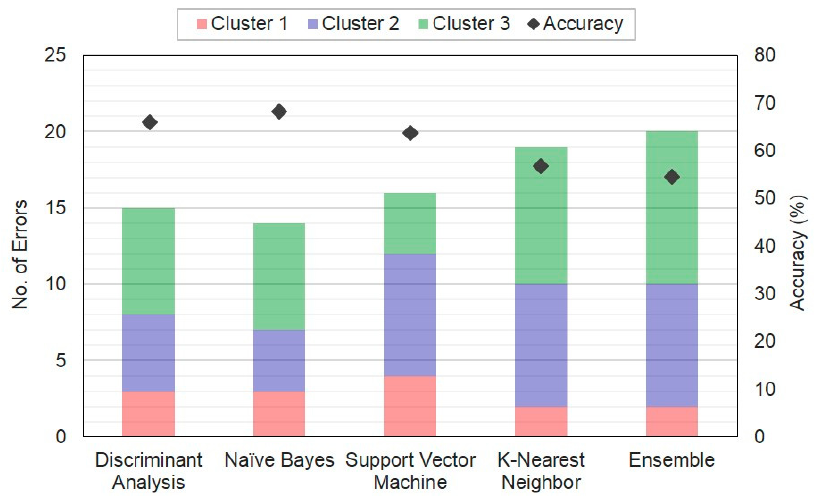
Figure 21. Classification results of group by machine learning methods for 3 attributes.